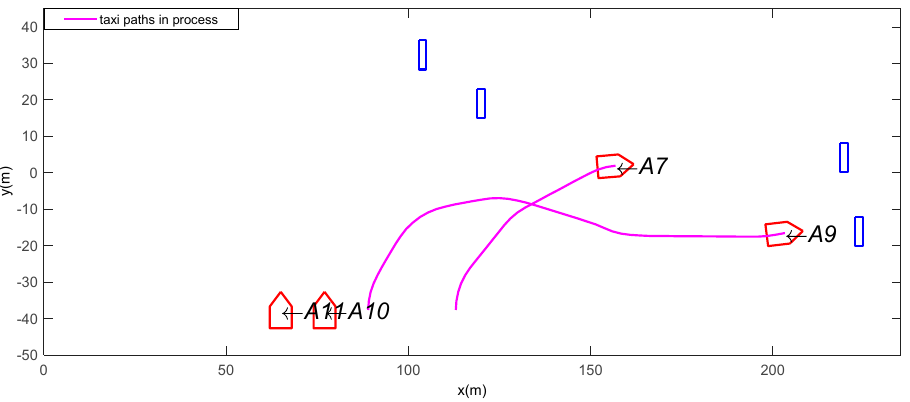
Figure 17. The state of aircraft when t = 80 s.